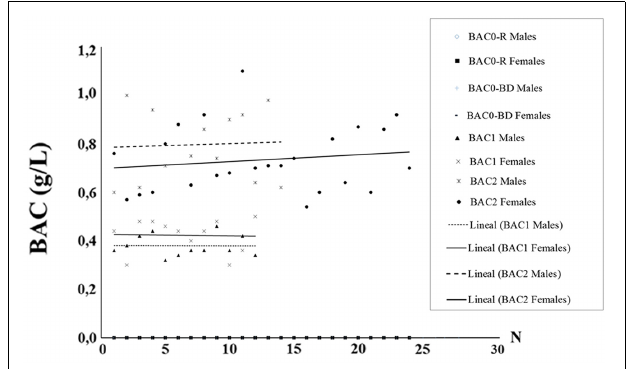
FIGURE 1 | Scatterplot depicting the distribution of BACs obtained in the sample of male and female